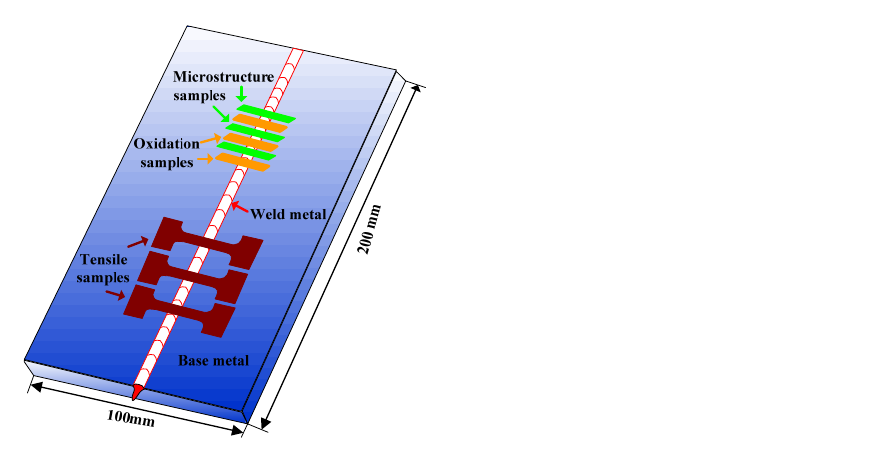
Figure 1. Schematic diagram of the weld joint and the sampling position of the thermal shock.